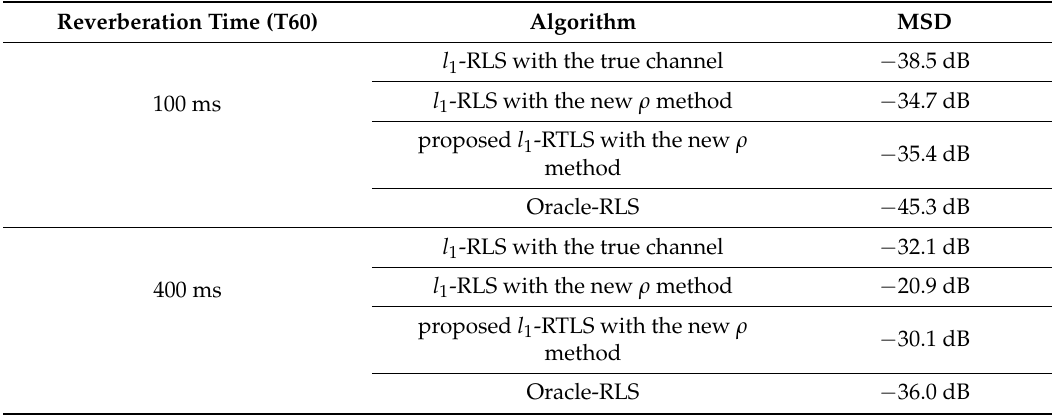
Table 3. MSD (mean square deviation) comparison in sparse RIR